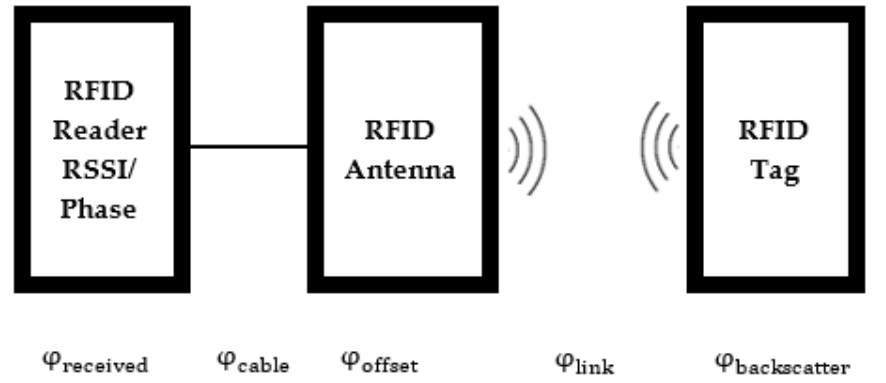
Figure 2. The signal phases in RFID systems.